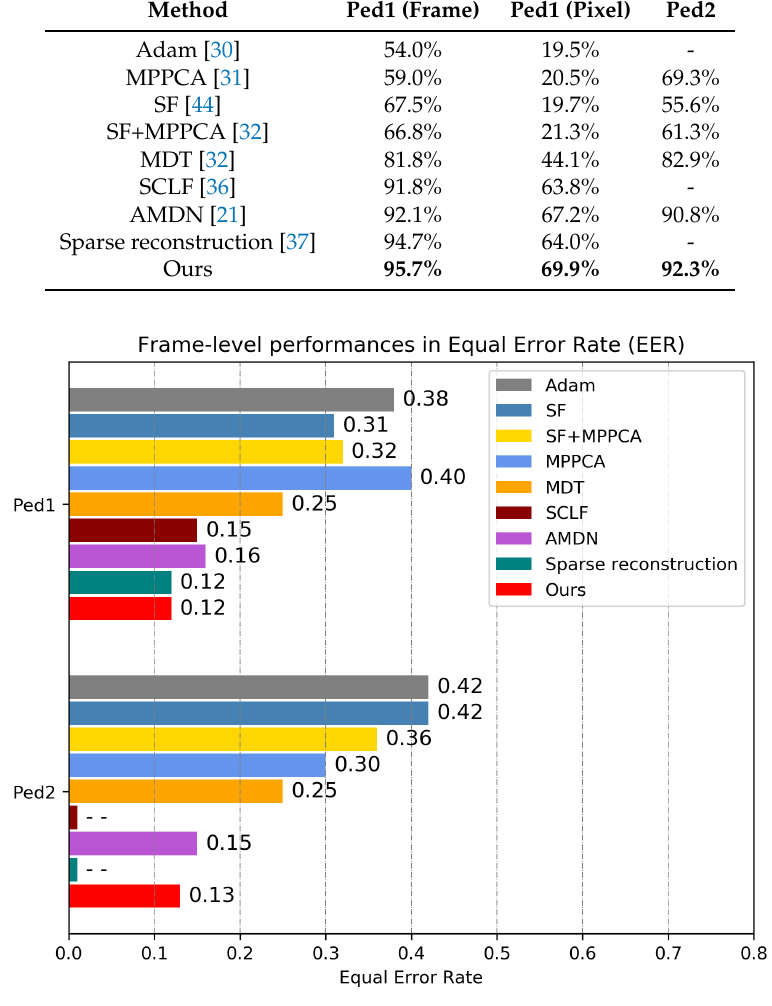
Figure 6. Equal error rate (EER) comparison of frame-level performance with different methods. Note that the performances of the sparse combination learning framework (SCLF) [36] and the sparse reconstruction [37] on Ped2 dataset are not